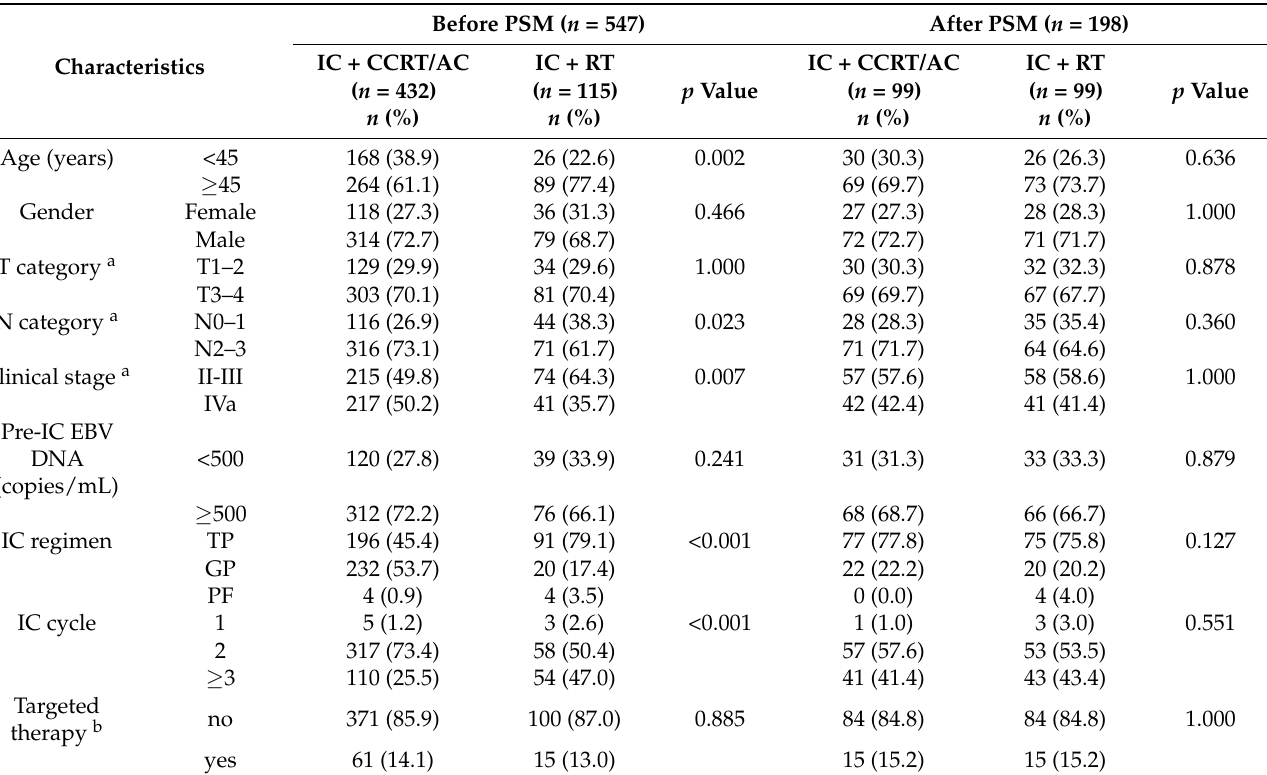
Table 1. Patient characteristics of the original and the PSM